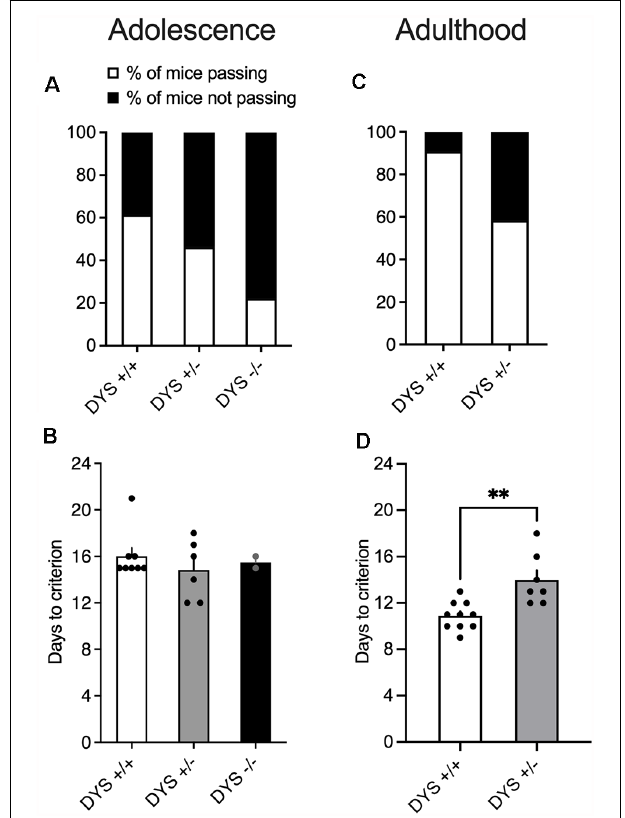
FIGURE 4 | (A) Percentage of mice finishing the entire task. 13 adolescent DYS + / + , 13 DYS + / − , and nine DYS − / − mice were tested. Five DYS + / + , seven DYS + / − , and seven DYS − / − mice were excluded because they were not reliably poking to retrieve the food reinforcement during the training or were not able to finish the entire procedure. All the other mice readily learned to poke in the holes for food rewards and were able to perform multiple sequences of discriminations. (B) The number of days taken by DYS + / + , DYS + / − , DYS − / − to complete the entire procedure of the ID/ED task (only those mice that finished the entire task are depicted in this bar graph). (C) Percentage of adult DYS + / + , and DYS + / − mice passing the entire task. (D) The number of days taken by DYS + / + and DYS + / − adult mice to complete the entire procedure of the ID/ED Operon task (only those mice that finished the entire task are depicted in this bar graph). Values represent mean ± SEM. DYS + / − adult mice need more days to reach the criterion compared to DYS + / + . ∗∗ p <